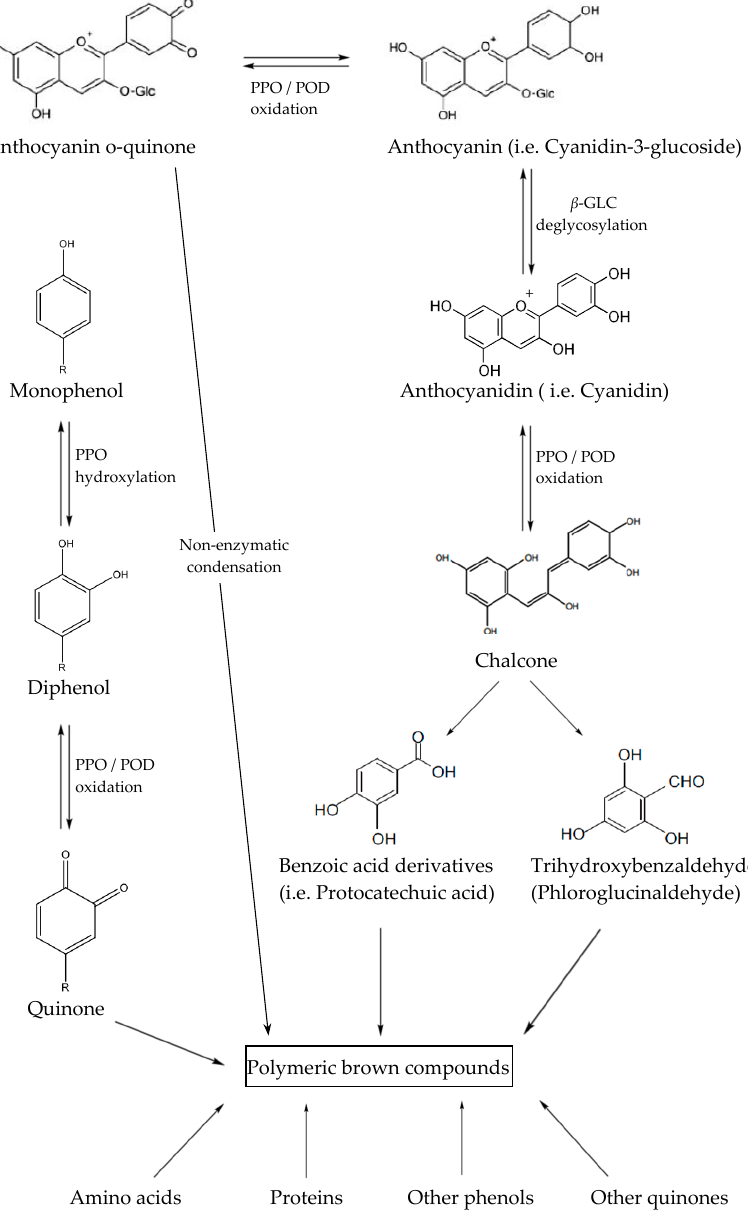
Figure 2. Scheme describing anthocyanins degradation. PPO: polyphenol oxidase, POD: peroxidase, Figure 2. Proposed scheme describing anthocyanins degradation. PPO: polyphenol oxidase, POD: 42 β -GLC: beta